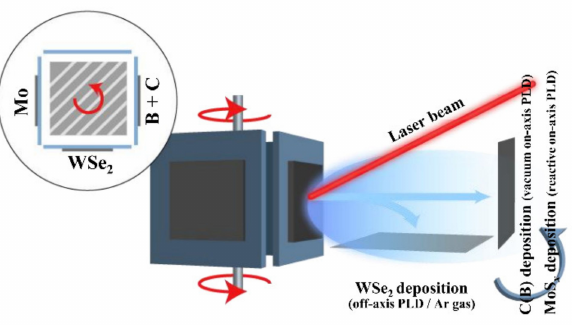
A schematic of the PLD technique employed to form functional layers in a MoS x ~4 /WSe 2 /C(B) heterostructure on a sapphire substrate. Comments are given in the text. A WSe 2 film was deposited by off-axis PLD on the surface of the substrate coated with a C(B) film. The substrate was rotated 90 ◦ and placed along the laser plume axis 2 cm away from the WSe 2 target, which was manufactured by cold pressing of WSe 2 powder